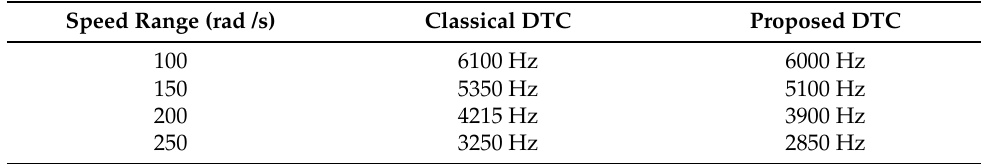
Table 5. Switching frequency comparison of classical and proposed